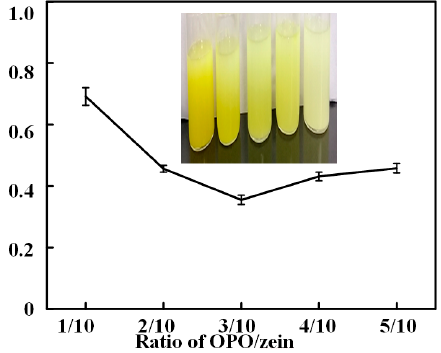
Figure 4. Turbidity of different OZN under 24 h at the room temperature.